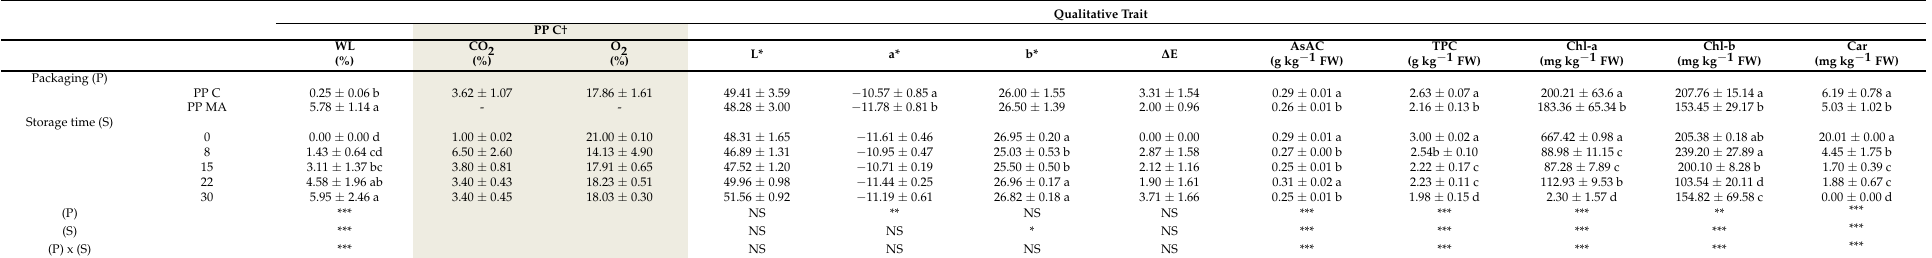
† Headspace carbon dioxide (CO 2 ) and oxygen (O 2 ) concentrations were monitored only on polypropylene micro-perforated bags (PP C), because PP MA (polypropylene macro-perforated bags) allowed non-controlled gas transfer. The levels of significance were represented by p > 0.05. NS, not significant; * significant at p < 0.05; ** significant at p < 0.01; *** significant at p < 0.001 according to Tukey’s